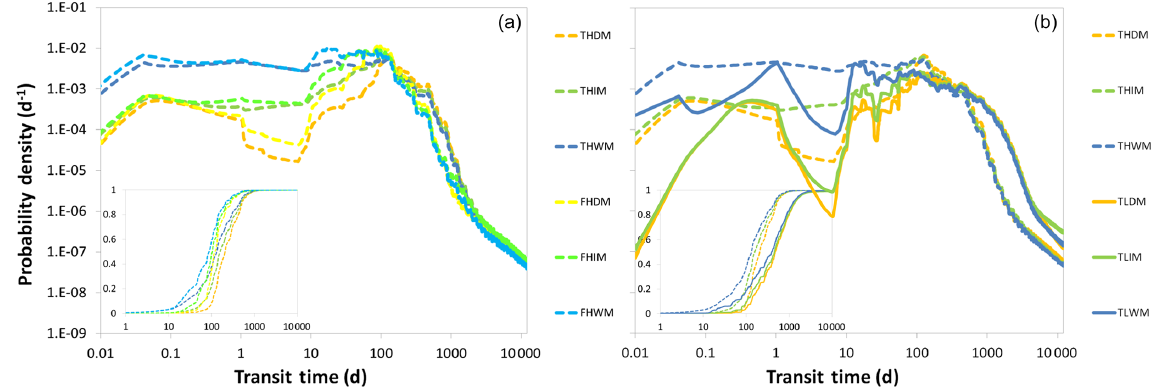
Figure 8. Influence of soil depth (a) and saturated soil hydraulic conductivity (b) on the shape of TTDs. Lighter shades of one color indicate shallower soils; dashed lines indicate higher hydraulic conductivity. Insets show cumulative